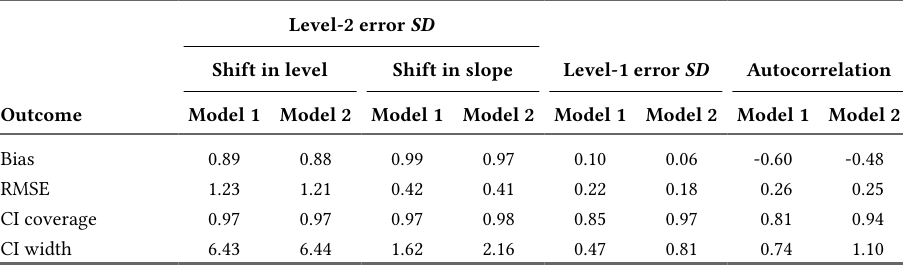
Average Relative Bias, RMSE, CI Coverage and Width for the Variance Components